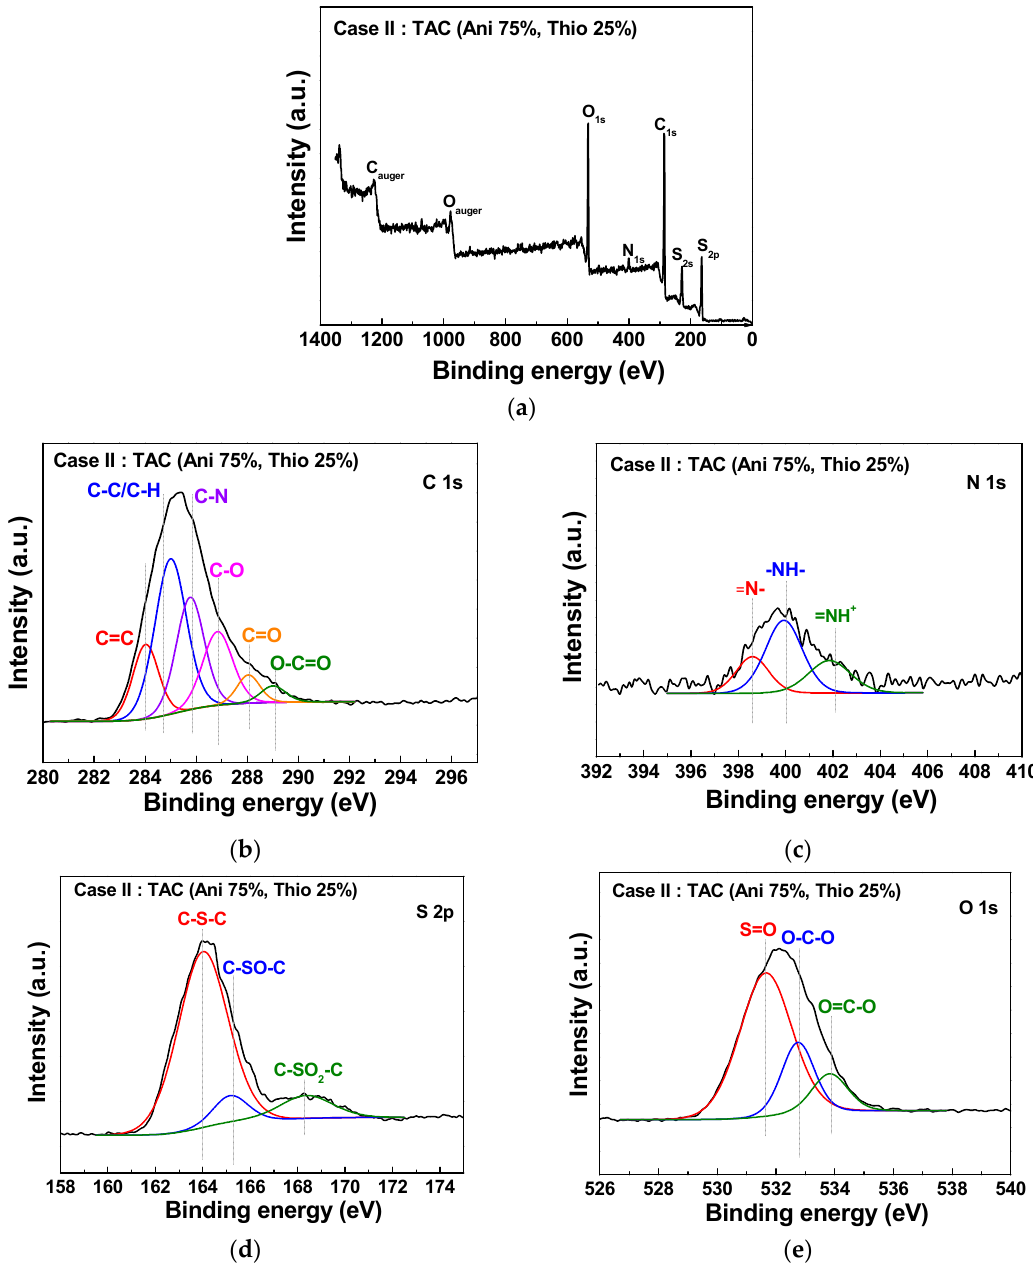
Figure 7. XPS survey spectra ( a ) and detailed high-resolutions with deconvolutions ( b – e ) of TAC films deposited on glass substrates by APPJs polymerization at blending condition of case II (aniline 75% and thiophene